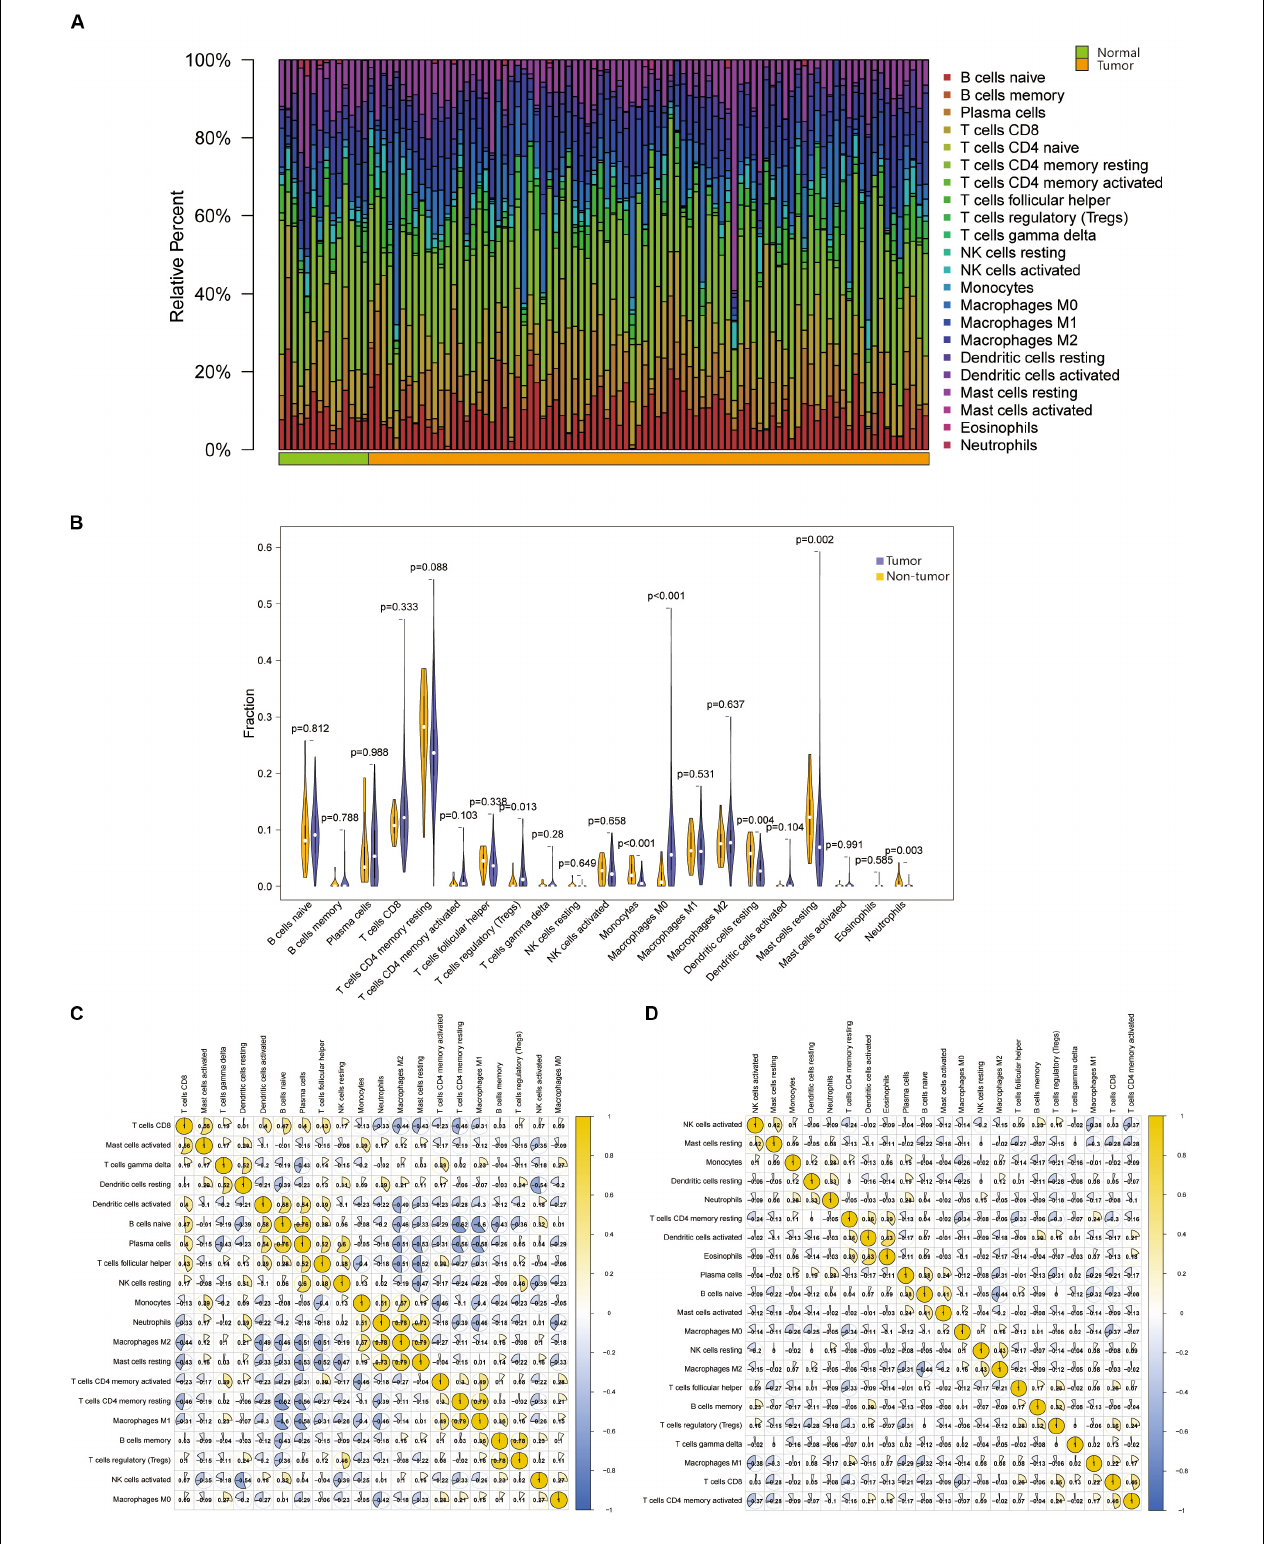
FIGURE 2 | (A) Relative proportions of 22 TIICs subpopulation in normal and PRAD samples. Stacked bar charts of samples ordered by cluster assignment. (B) The Violin plot exhibits the difference between CIBERSOFT immune cell fractions between normal tissues and tumor tissues by Wilcox t text. (C,D) The correlation matrix of all 22 immune proportions in the TCGA PRAD cohort, including normal samples, and tumor samples.